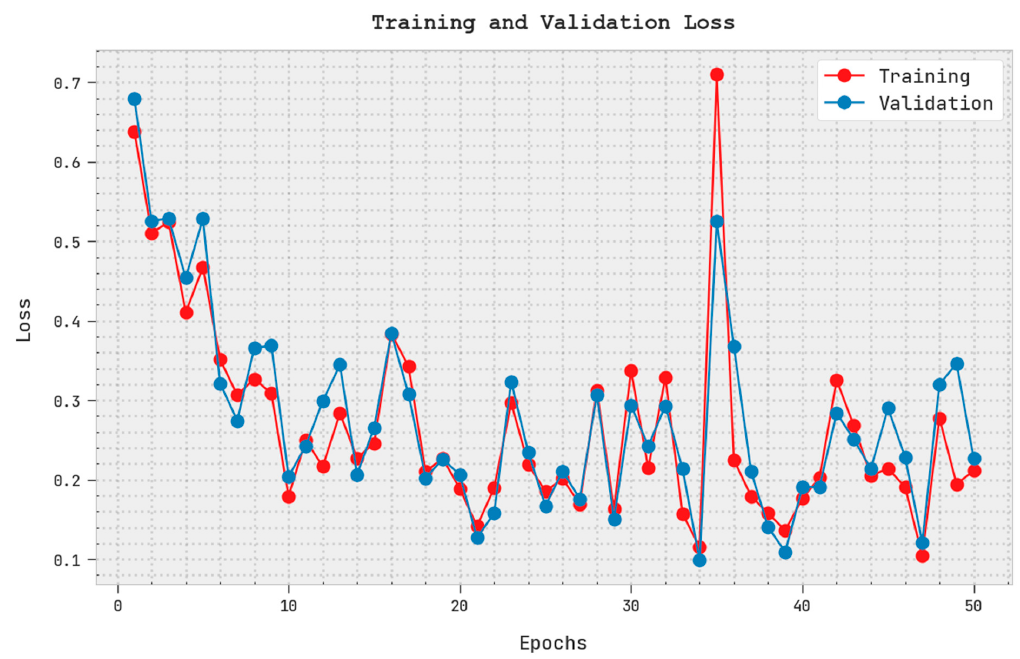
Figure 7. TRL and VLL analysis of PODCNN-LWID approach.